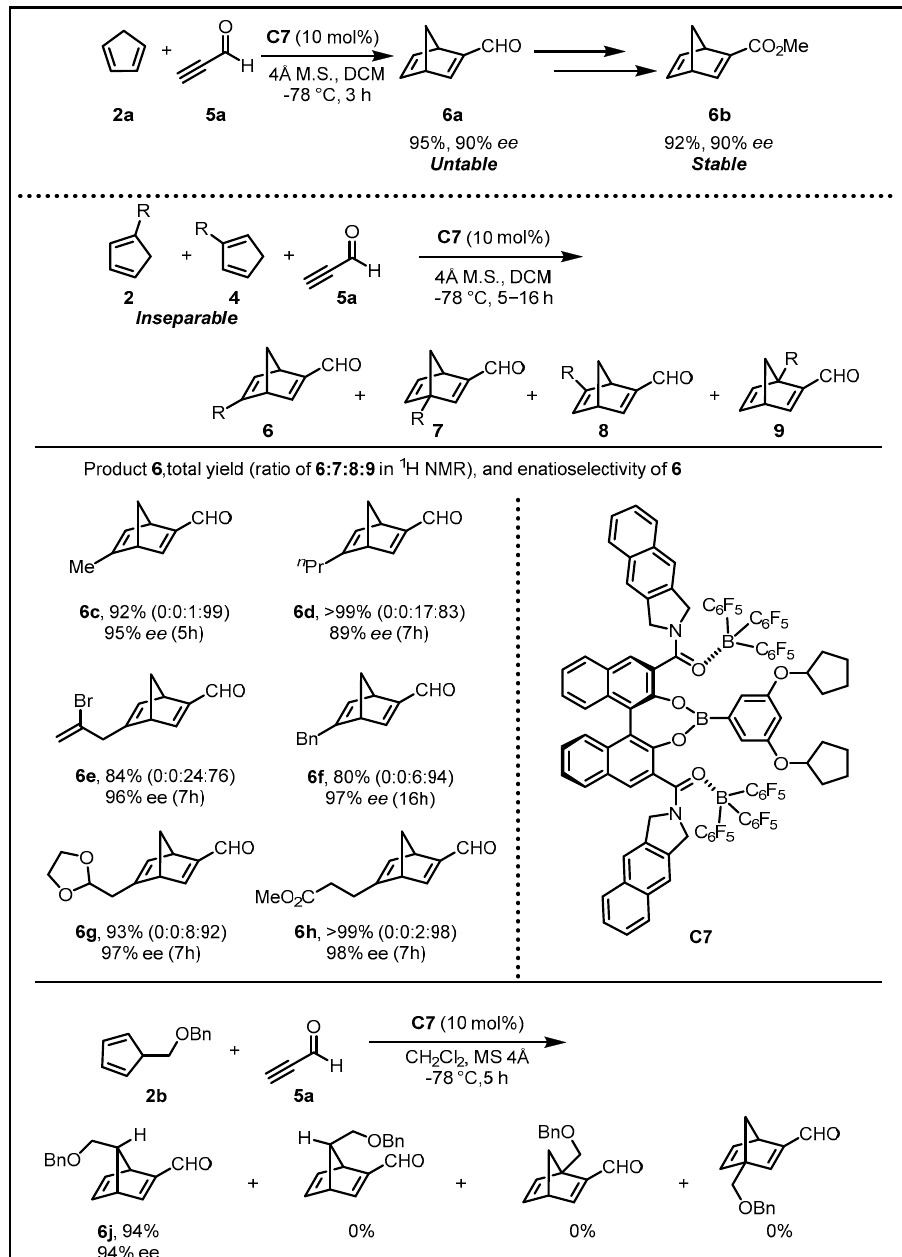
Figure 4. LLA-induced enantioselective Diels–Alder reactions with high multiselectivities.